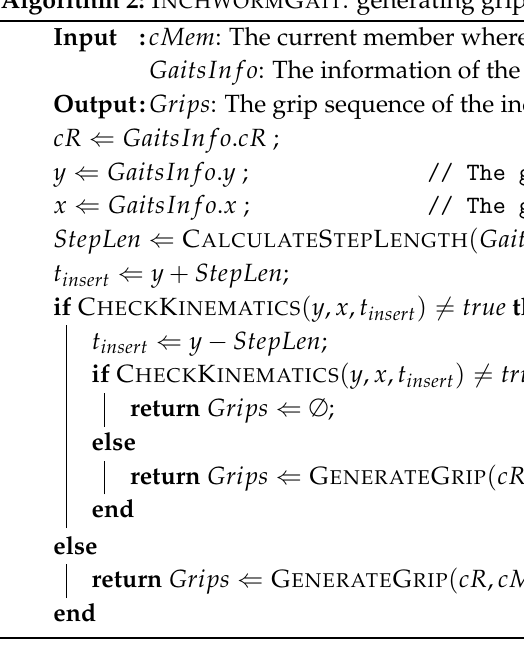
Algorithm 2: I NCHWORM G AIT : generating grips for the inchworm-like